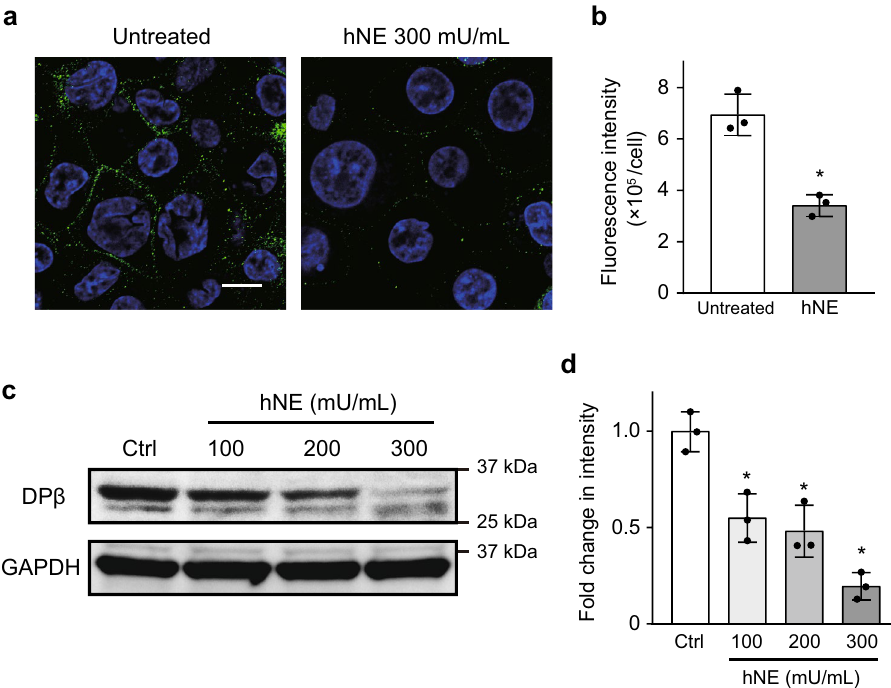
Figure 2. Neutrophil elastase (NE) decreases the fluorescence intensity of HLA class II on macrophages. THP-1-derived macrophages were cultured in RPMI 1640 and exposed to hNE (100–300 mU/mL) for 6 h. ( a ) Representative fluorescence microscopy images of untreated and 300 mU/mL hNE-treated macrophages stained for DNA (DAPI; blue) and HLA class II (HLA-DP β1; green) are shown. Scale bar: 10 µm. ( b ) The fluorescence intensity of HLA class II per cell was calculated. Data represent the mean ± SD of triplicate experiments and were evaluated using unpaired t tests. *Significantly different from the untreated control group at P < 0.01. ( c ) HLA-DP β1 expression in macrophages was determined by Western blot analysis. ( d ) Intensity of Western blotting signals of HLA-DP β1 in macrophage was quantified by densitometry. Data represent the means ± SD of triplicate experiments and were evaluated by one-way analysis of variance with Dunnett’s multiple-comparisons test. *Significantly different as compared with that of the control group at P <